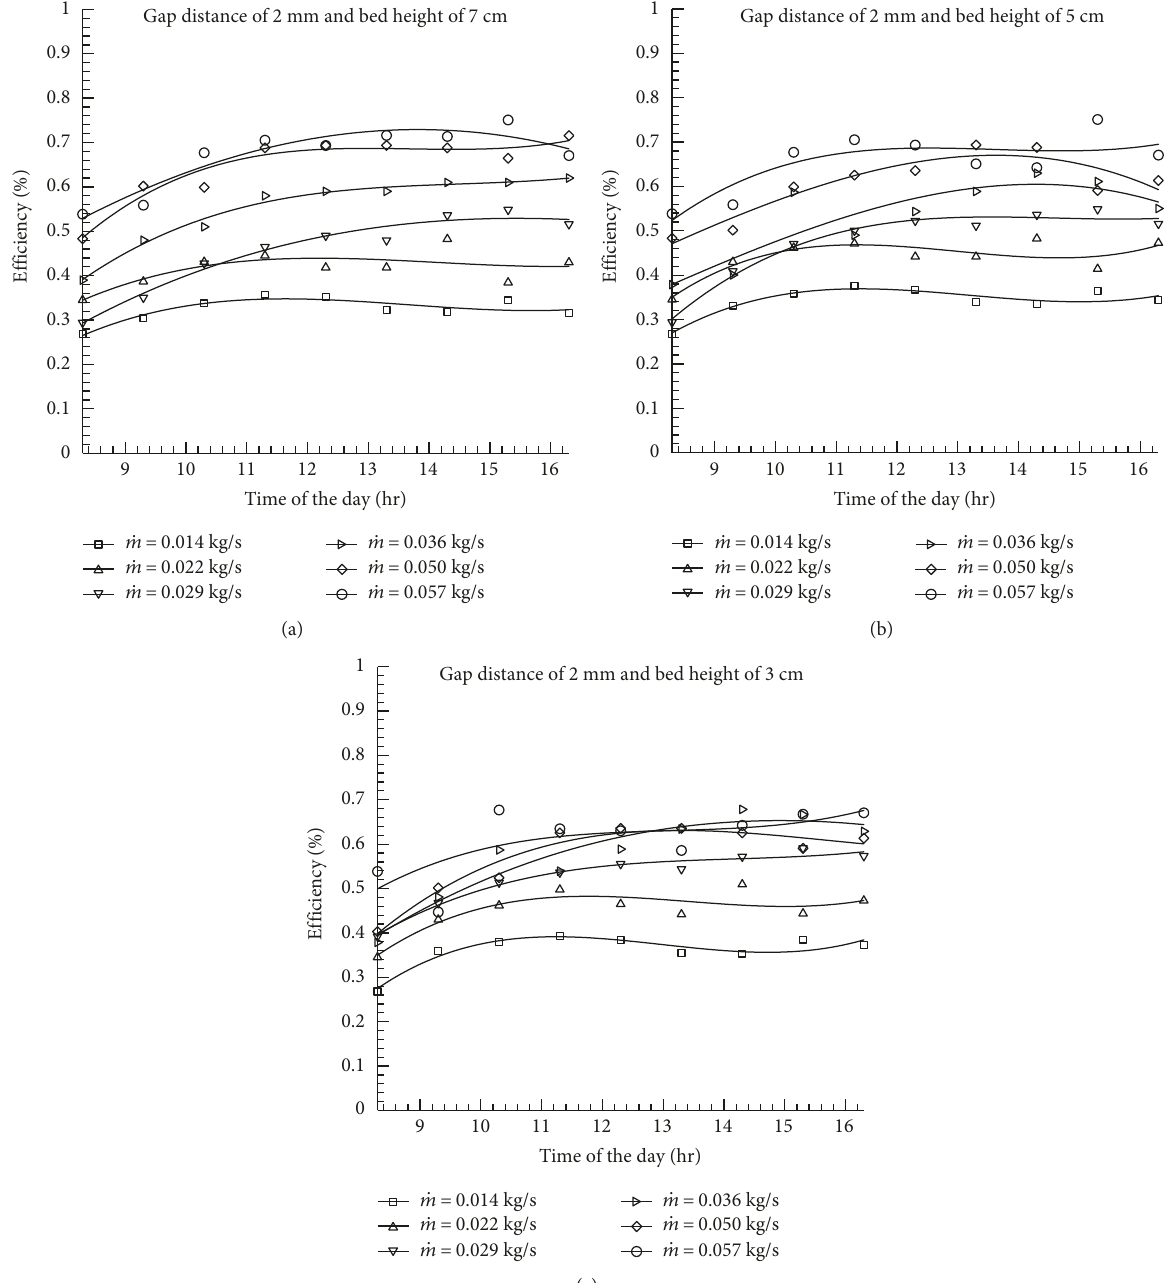
Figure 10: Thermale ffi ciencyversustimeatthegapdistanceof2 mmforbedheights(a)7 cm,(b)5cm,and(c)3 cmanddi ff erentmass fl